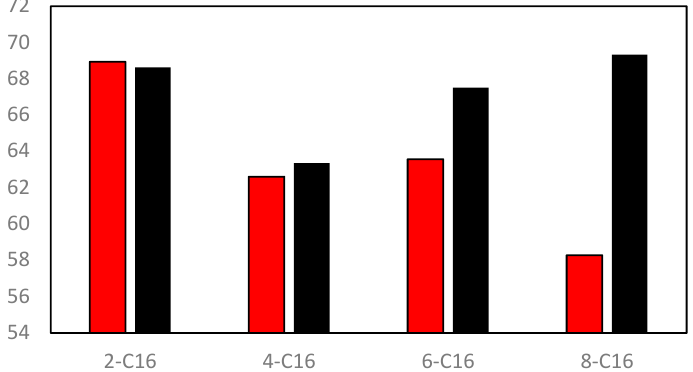
Figure 13. Average benzene vector and average tail vector (red is θ b and black is θ t ).